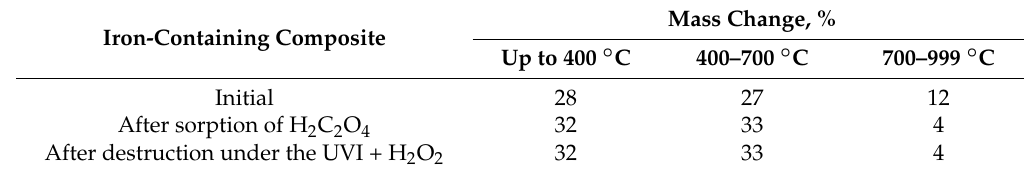
Table 2. Data on the changing of iron-containing peat composites at their thermal destruction, depending on the conditions of oxalic acid removal from the model solutions. Iron-Containing Composite